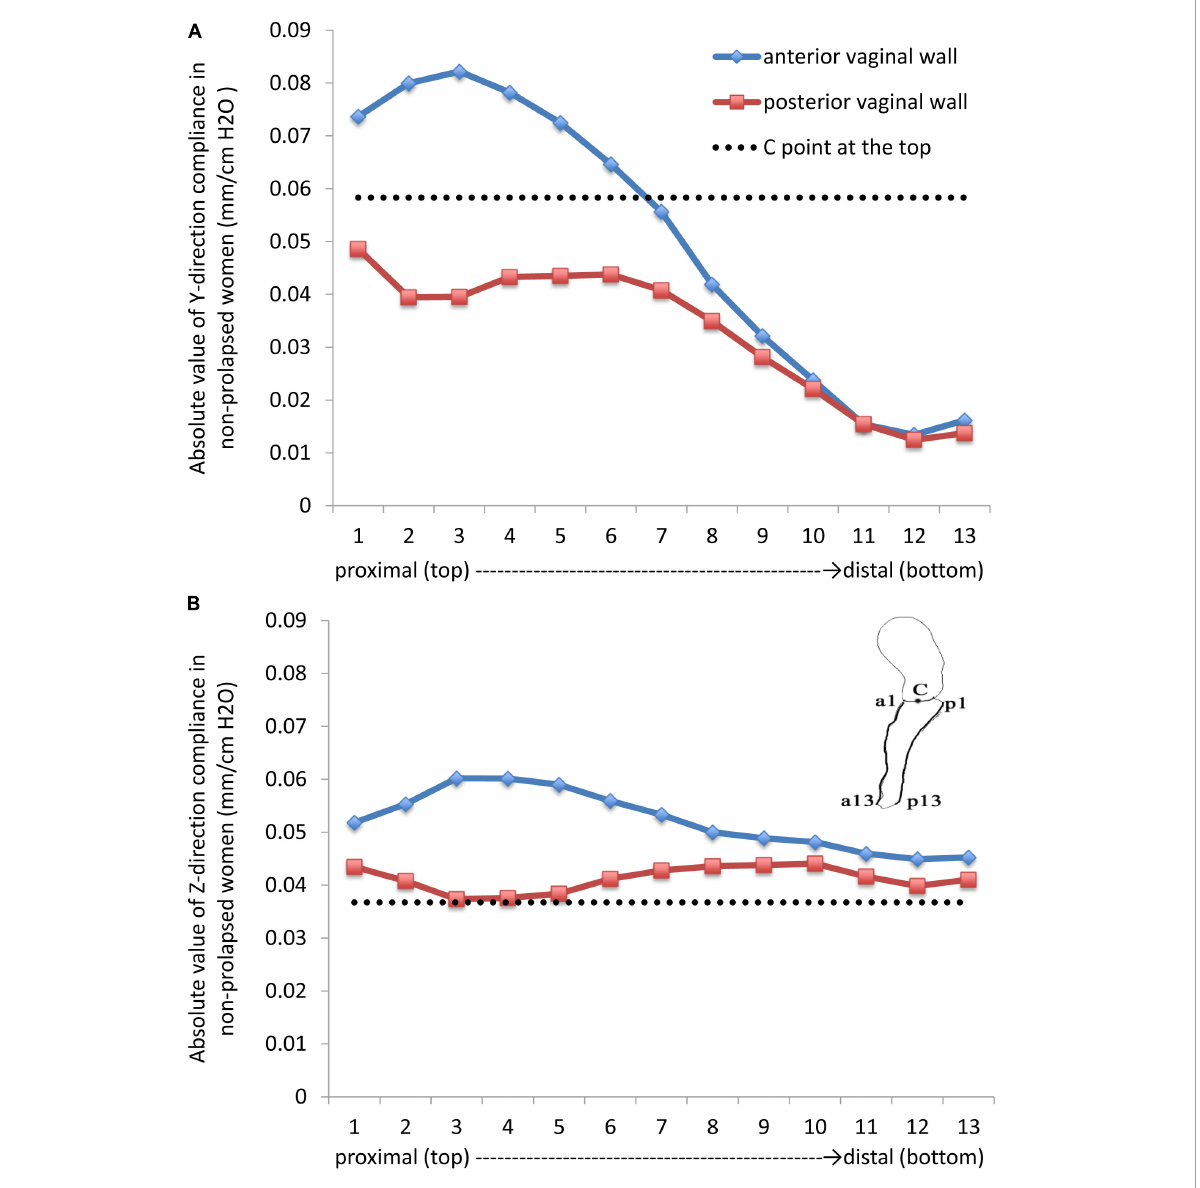
FIGURE2 Absolute values in the (A) (forward and backward) Y direction and (B) (vertical) Z direction compliances in non-prolapsed women.